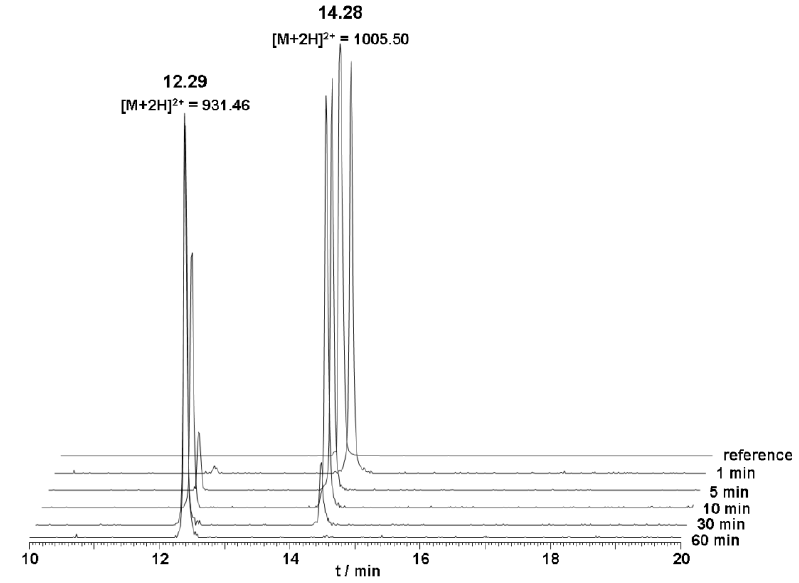
Figure 2. Serum stability of DOTA-Lys-DUP-1. The peptide was incubated in human serum at a concentration of 10 − 4